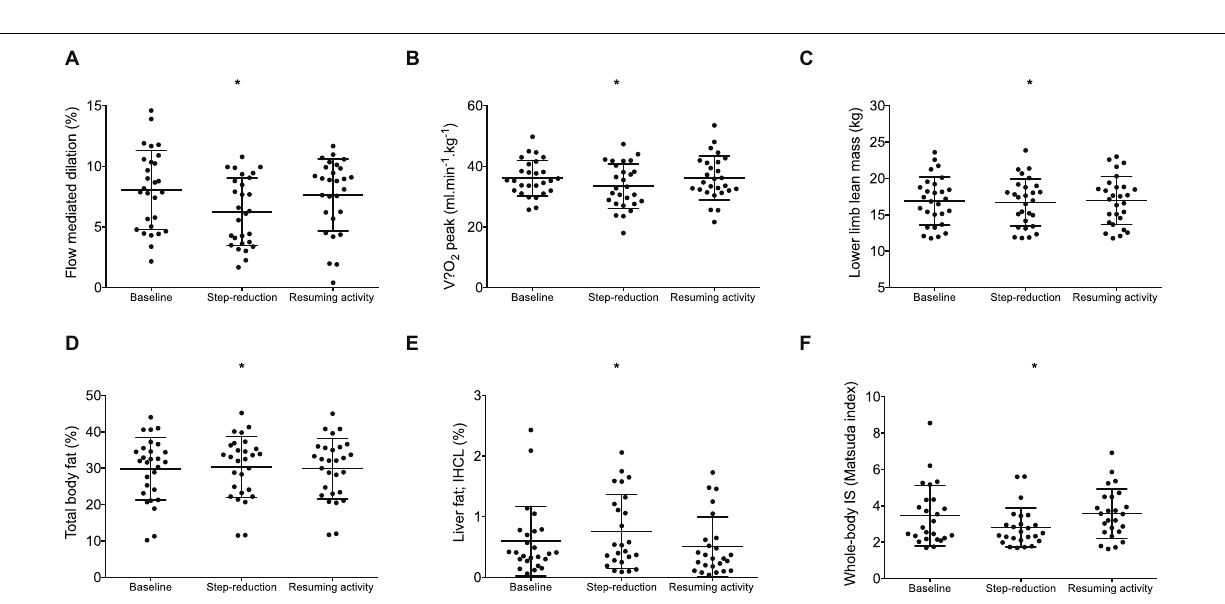
FIGURE 2 | Data for individuals at baseline, following step- reduction and resumption of activity. Flow mediated dilation; FMD (A) , ˙VO 2 peak (B) , lower limb lean mass (C) , total body fat (D) , liver fat; IHCL (E) , and whole-body IS (F) . Data are presented as mean ± SD; * P < 0.05 main effect of time.